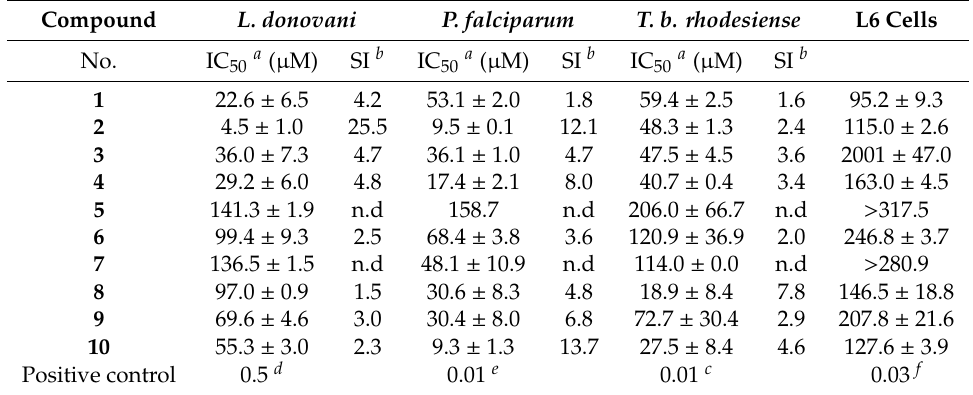
Table1. In vitroActivityofcompounds 1 − 10 against L.donovani (MHOM-ET-67 /